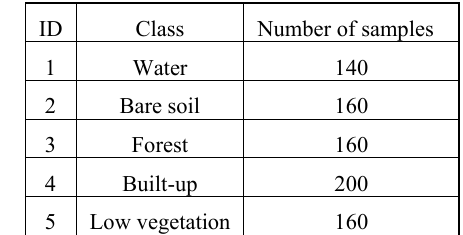
Table 3. Overview of the land-cover classes used in this research.